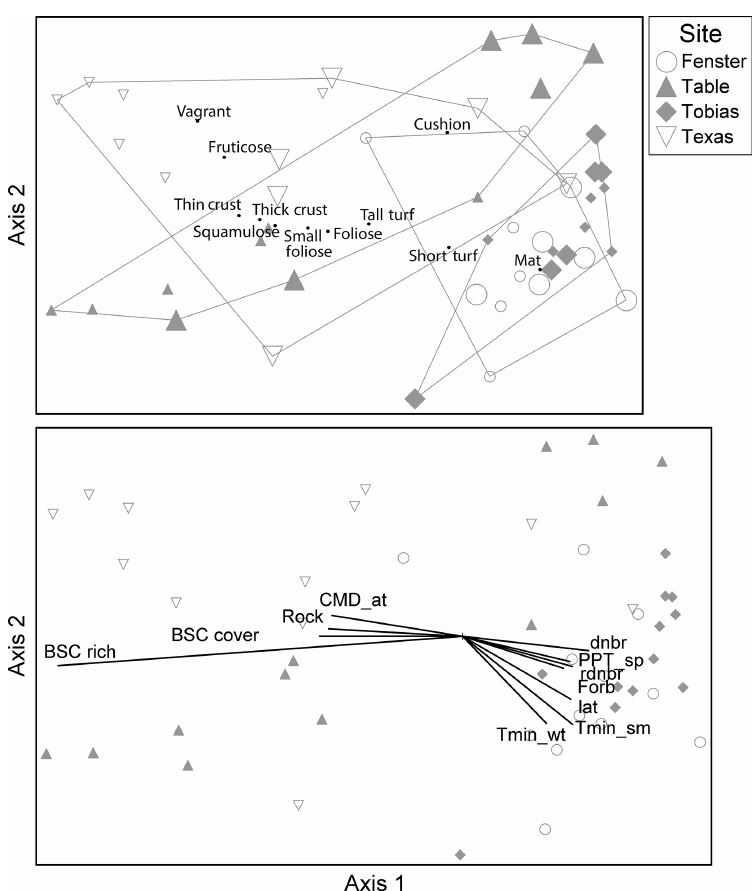
Figure 4. Ordination of BSC growth forms found at four sites in Idaho, USA. Each gray point represents a plot, with points closer to each other having a more similar composition of BSC growth forms. Plots from the same site have the same symbol. In the upper panel, plots are larger if they are within the fire perimeter and smaller if they are unburned; plots from the same site are connected into a polygon using gray lines. Small black circles represent the centroid of each BSC growth form on the ordination. In the lower panel, labeled vectors show relationships between variables and the ordination axes with R 2 > 0 . 20, including BSC richness and cover, rock and forb cover, latitude (lat), and fire severity metrics (dNBR and RdNBR). Climate variables include climatic moisture deficit in autumn (CMD_at), precipitation in spring (PPT_sp), and minimum temperature in summer and winter (Tmin_sm,